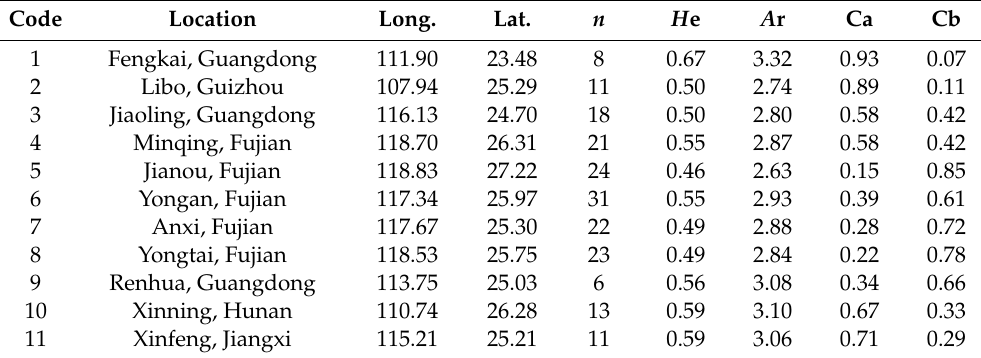
Table 1. Sampling sites and genetic diversity of Quercus